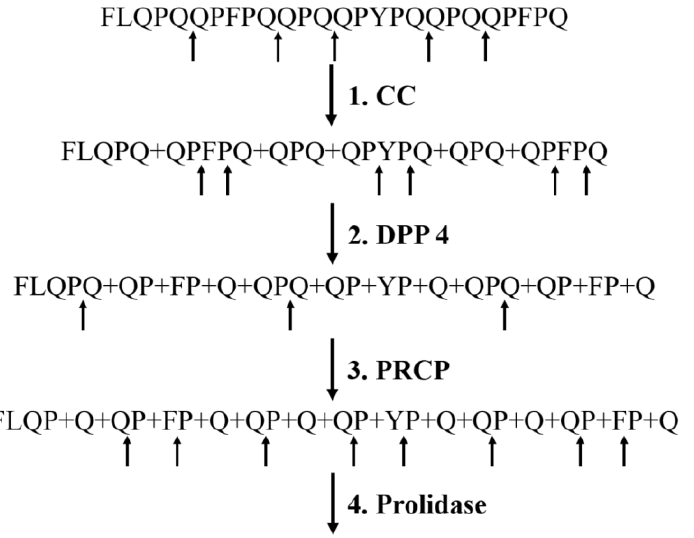
Figure 4. Hypothetical scheme for the complete hydrolysis of glutamine- and proline-rich 26-mer immunogenic gliadin fragments by T. molitor and T. castaneum digestive CC and PSPs.